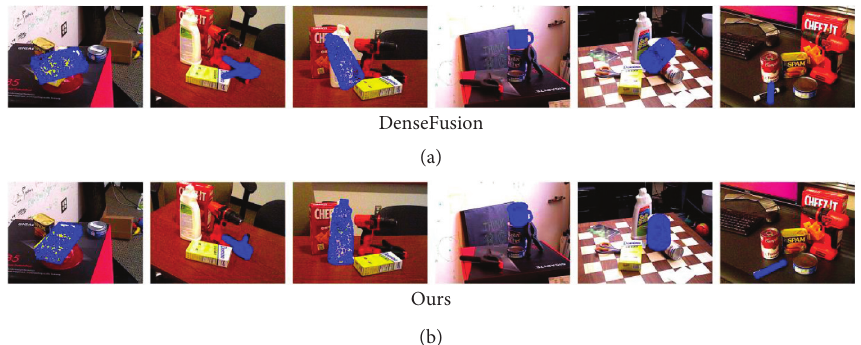
Figure 3: Qualitative comparison on 6D pose estimation performance between the proposed approach and previous work [8] with the YCB- Video dataset. Our method achieves more accurate pose estimation on a variety of objects.